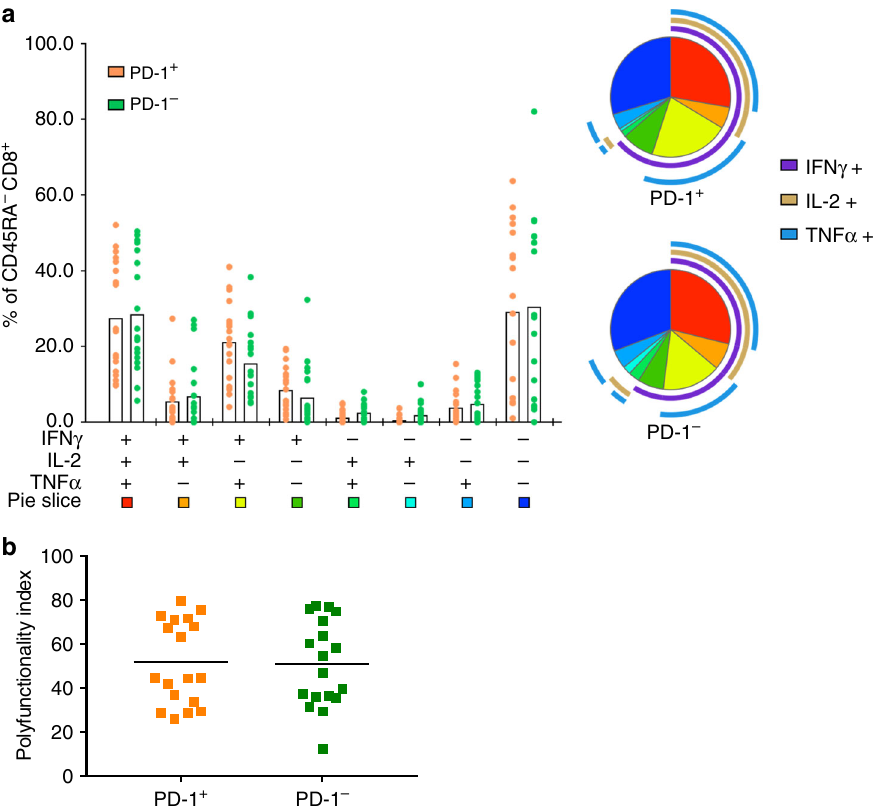
Fig. 6 PD-1 + CD8 + TILs from breast tumors retain polyfunctional effector cytokine production capacity. a CD8 + T cells from bcTumor tissues were stimulated with PMA and ionomycin for 4 h followed by intracellular staining for IFN γ , TNF α , and IL-2 production and surface staining for PD-1. SPICE graph visualizes frequencies of bcTumor non-naive PD-1 + CD8 + T cells and non-naive PD-1 − CD8 + T cells expressing IFN γ , TNF α , and IL-2 in bcTumor with each symbol representing one patient tissue sample in each category. Summary pie graphs generated represent adjusted means for each population color-coded in the bar graph and display the phenotype of IFN γ , TNF α , and IL-2 production in those populations. b Graph depicts calculated polyfunctionality indices for each sample type based on frequencies of bcTumor non-naive PD-1 + CD8 + T cells and non-naive PD-1 − CD8 + T cells expressing IFN γ , TNF α , and IL-2. c CD8 + T cells from sentinel lymph node tumor negative (SLN T − ) or tumor positive (SLN T + ) tissues were stimulated with PMA and ionomycin for 4 h followed by intracellular staining for IFN γ and TNF α . Each symbol represents a single patient tissue